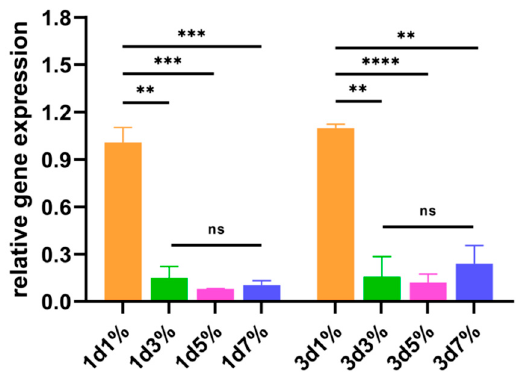
Figure 10. Real-time PCR analysis of the gene expression of the IL-1, n =3, ns represents p > 0.05, ** p < 0.01, *** p < 0.001, **** p < 0.0001.